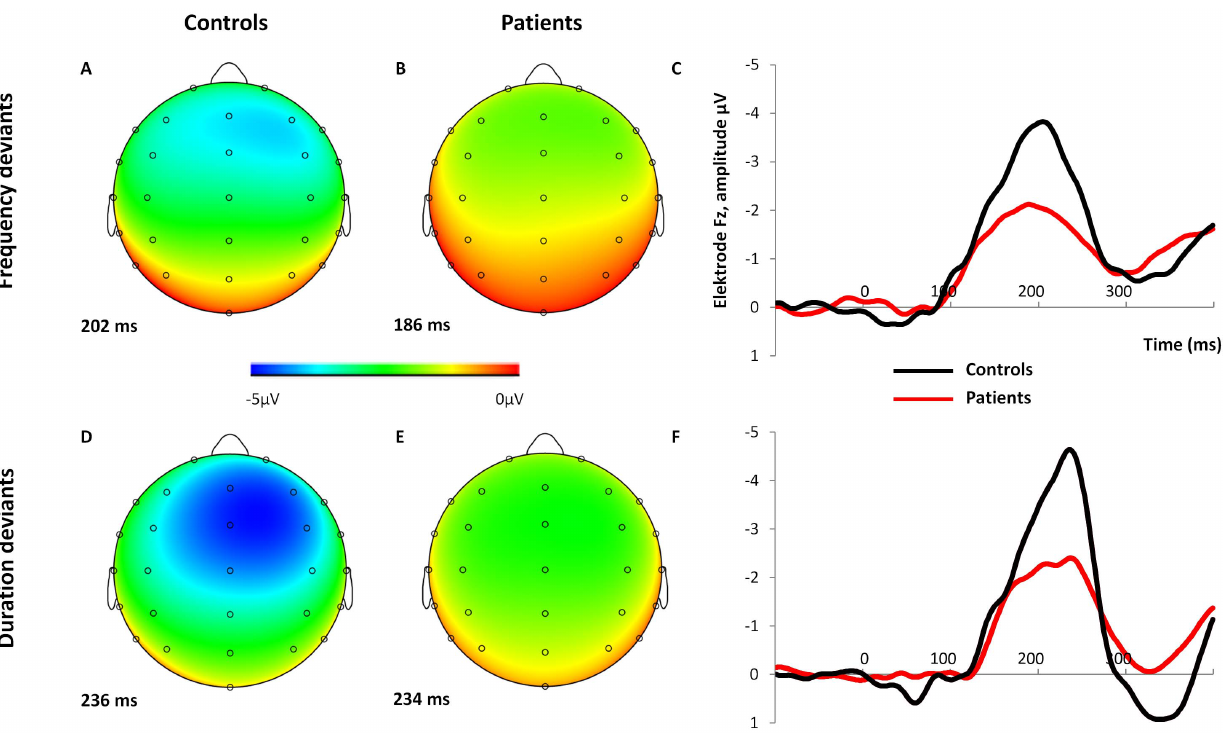
Figure 2. 28 channel EEG amplitude distributions and comparison of the between-group MMN waveforms. Scalp electrode maps of MMN to frequency deviant (A, B) and duration deviant tones (D, E) in controls (A, D) and patients (B, E). MMN waveforms of patients and controls to frequency (C) and duration deviant tones (F), both at Fz are shown on the right.